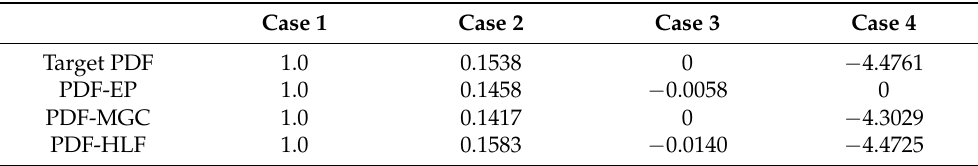
Figure 5. CDFs of the three methods. ( a ) Case 1. ( b ) Case 2. ( c ) Case 3. ( d ) Case 4. Tables 1 and 2 shows the calculated mean and variance using the different methods for the different target PDFs, while Table 3 summarizes the control errors. Table 1. Means of the PDFs based on the three methods